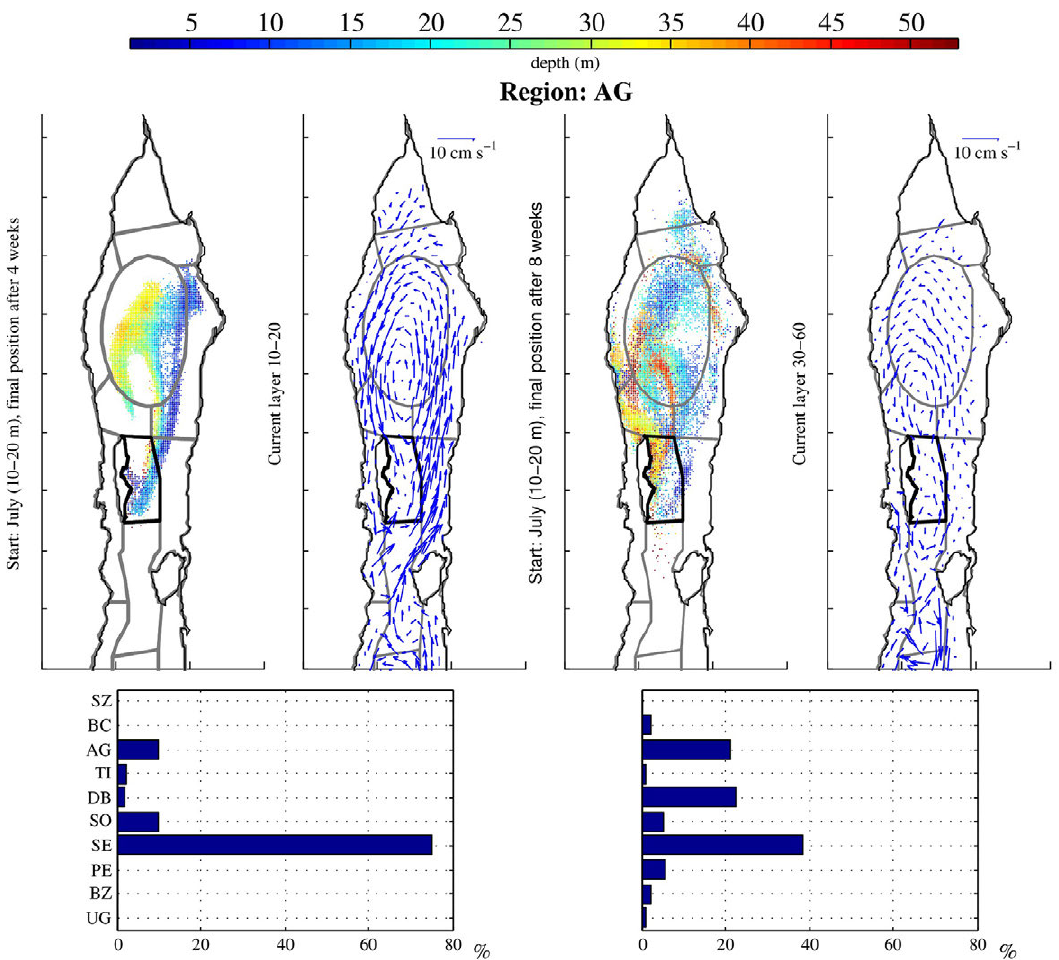
Fig. 11. – Map of final position of particles released in the east of the Ángel de la Guarda island’s second layer, in the fourth and eighth week after the release of particles. The release area is shown in black and the other areas in grey polygon. The colour bar represents the depth at which each particle is located. The histogram shows the percentage of particles retained or transferred to other regions. Current maps cor- respond to the layer in which the percentage of particles retained is concentrated, in the fourth and eighth week after particle